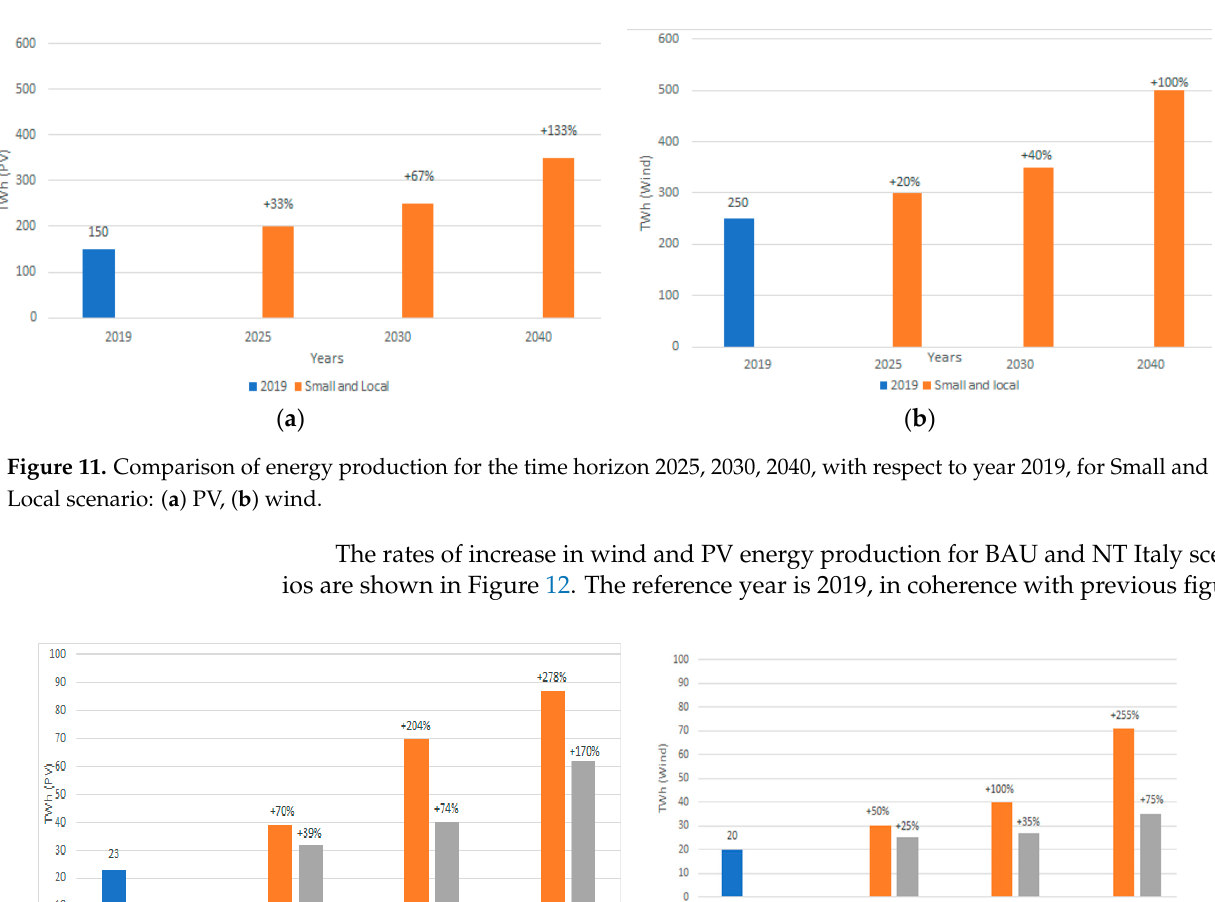
Figure 12. Comparison of energy production for the time horizon 2025, 2030, 2040, with respect to year 2019, for both BAU and NT Italy scenarios: ( a ) PV, ( b ) wind.